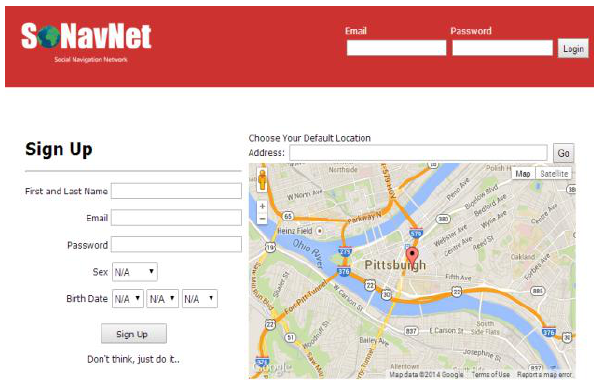
Figure 1. Main page of